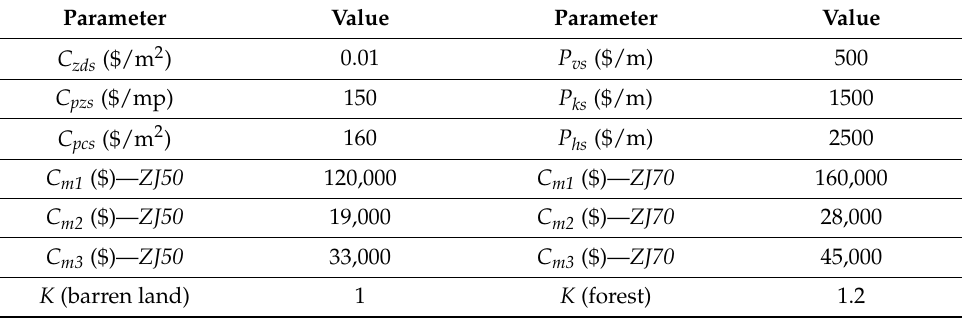
Table 1. Basic calculation parameters obtained from